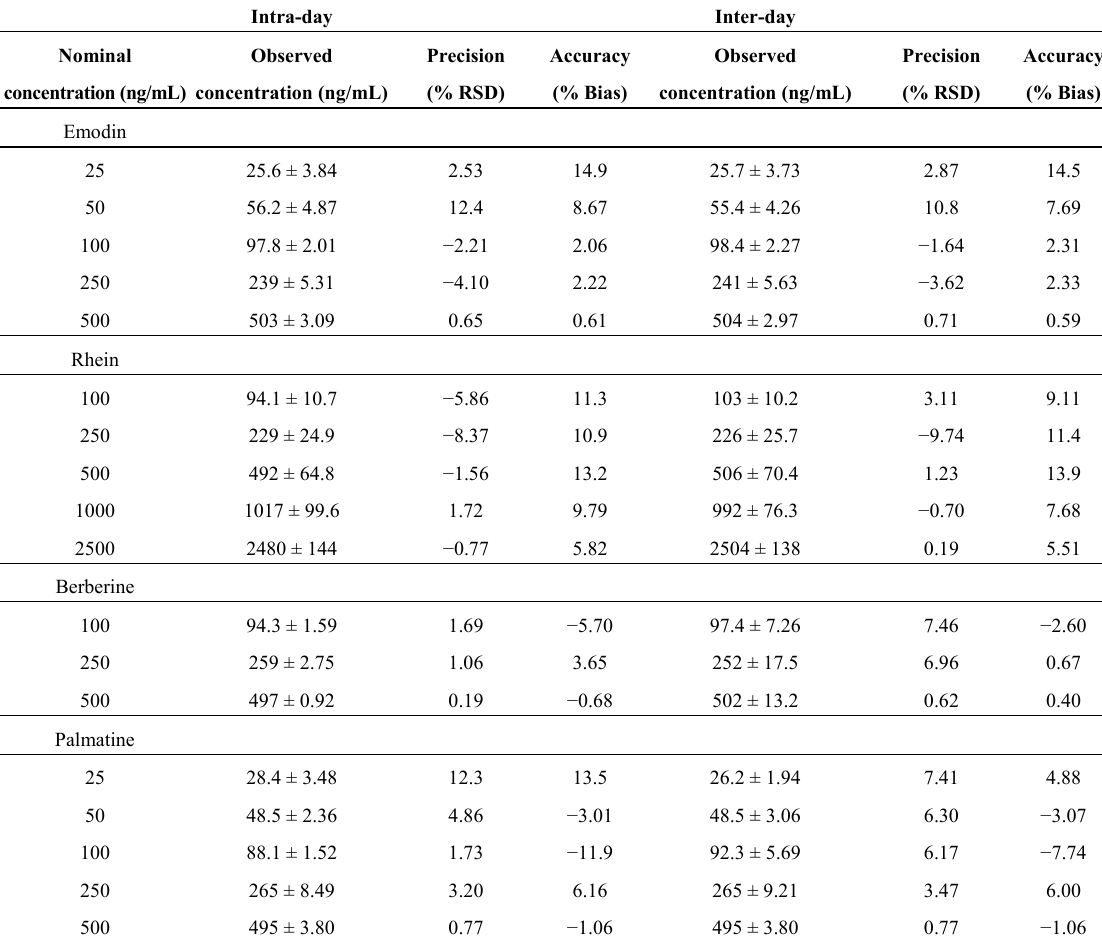
Table 1. Intra- and inter-day precision (% RSD) and accuracy (% bias) of the UPLC-MS/MS method for determination of analytes in commercial pharmaceutical herbal products (6 days, six replicates per